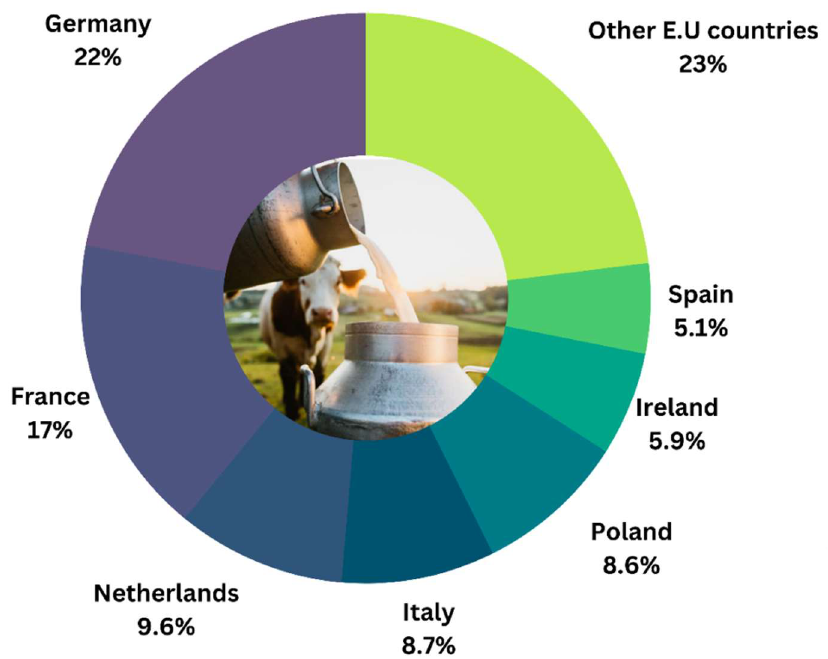
Figure 1. The graph shows the percentage of milk produced by EU countries (except Luxembourg) 2020 (Eurostat, in 2020 (Eurostat, 2021).